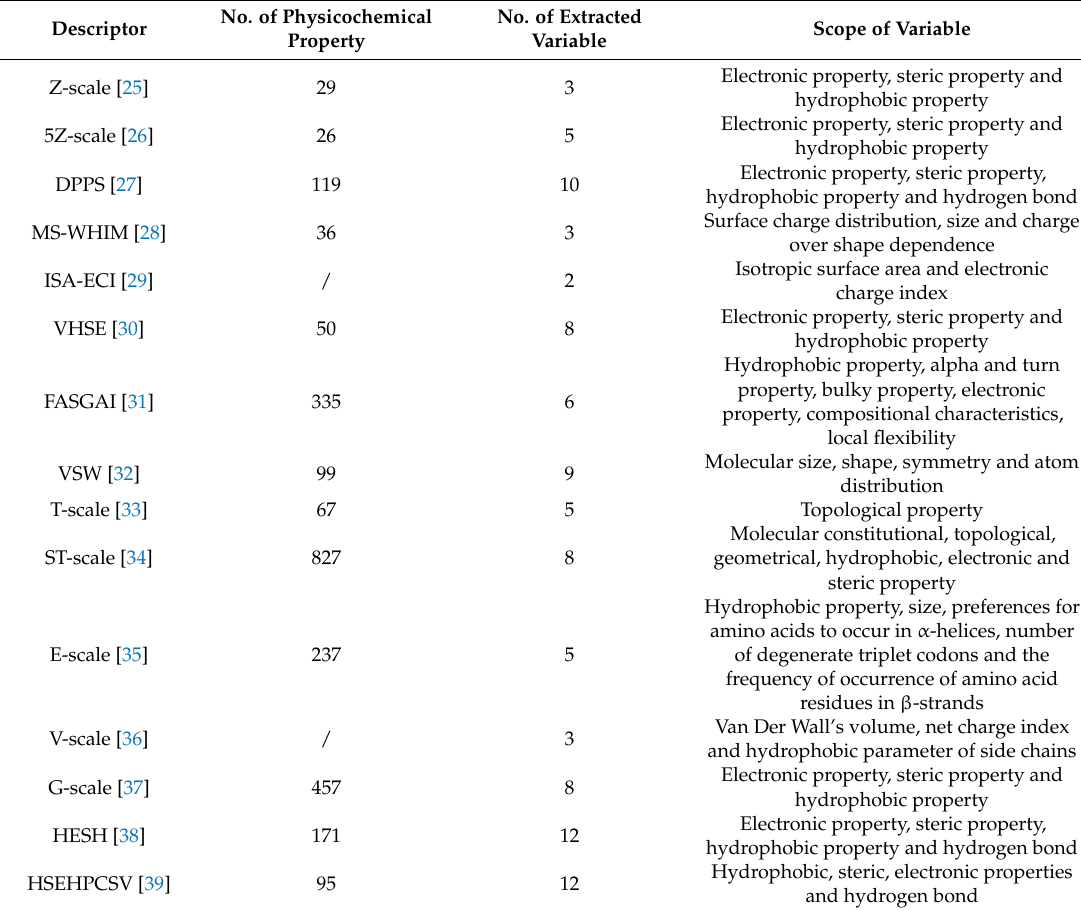
Table 5. Parameters of 16 amino acid